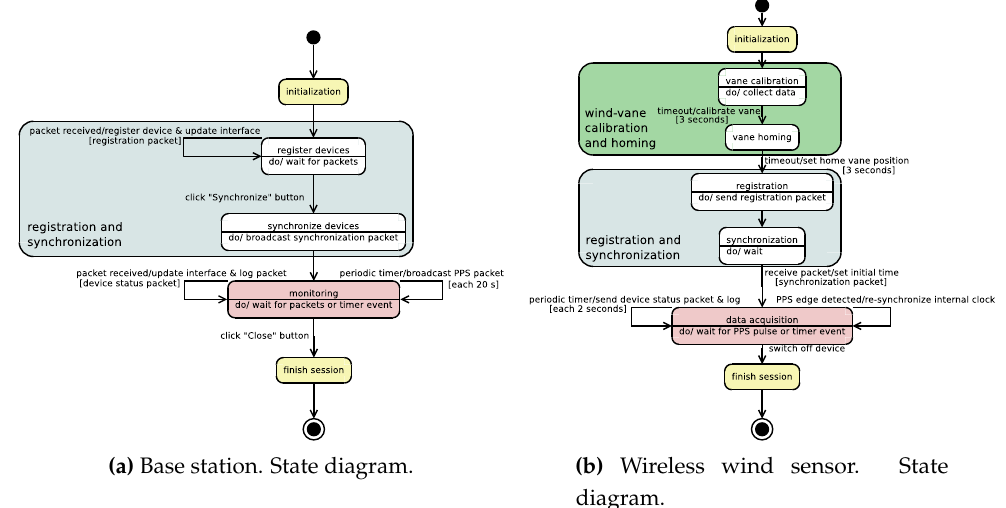
Figure 4. Wind data acquisition system—state